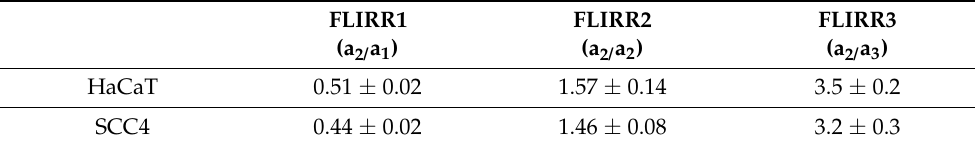
Table 4. FLIRR indices for HaCaT and SCC4 cells. FLIRR1 is the ratio between a 2 (NAD(P)H) and a 1 (flavins), FLIRR2 is the ratio of a 2 (NAD(P)H) and a 2 (flavins) and FLIRR3 is the ratio of a 2 (NAD(P)H) and a 3 (flavins). For the calculations, a three-exponential free lifetime fit decay analysis was performed for flavins and a two-exponential fixed lifetime fit decay for NAD(P)H with τ 1 = 400 ps and τ 2 = 2.5 ns.